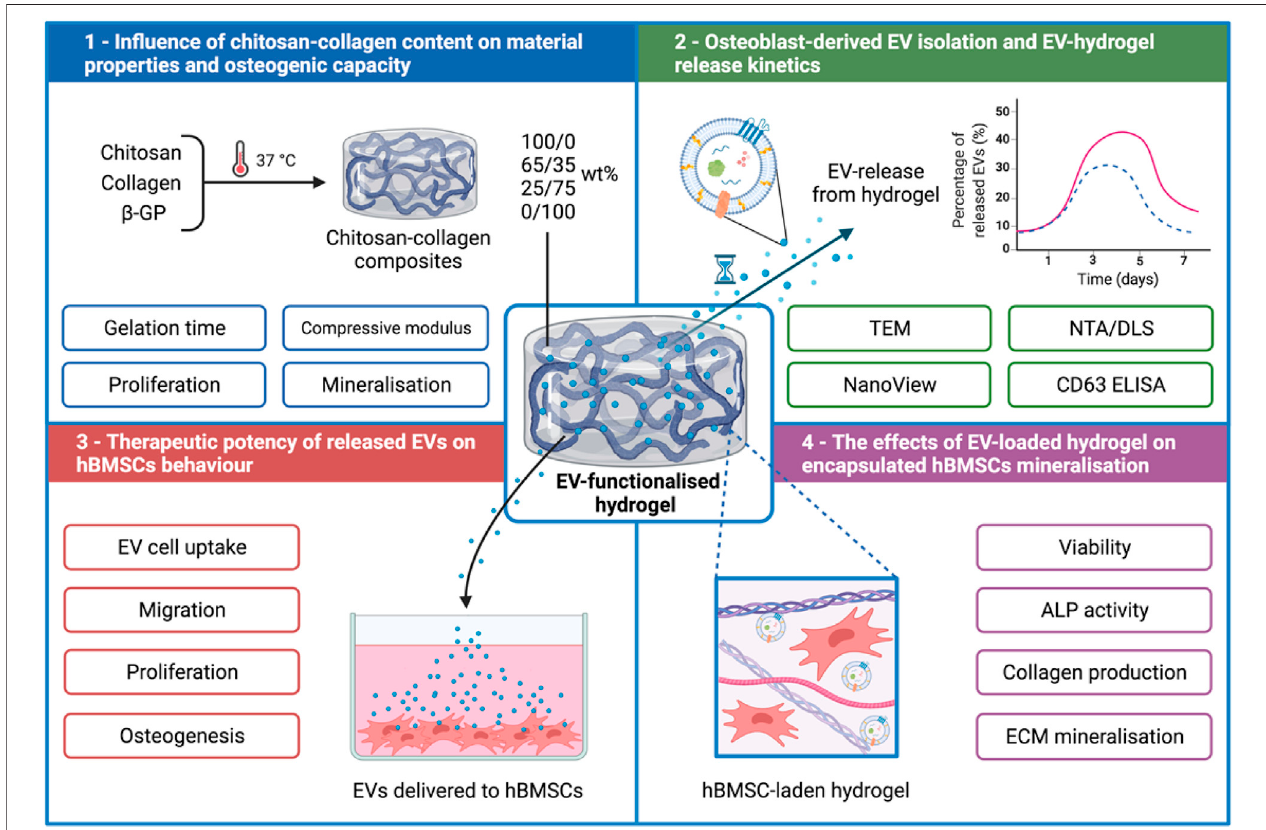
FIGURE 1 | Experimental outline detailing the development of a chitosan-collagen composite hydrogel for promoting EV therapeutic ef fi cacy for site speci fi c bone regeneration.1)Thein fl uenceofchitosan-collagenhydrogelcontentonmaterialpropertiesandosteogenicdifferentiation.2)EVisolation,characterisation,andhydrogel- EV release kinetics. 3) The biological ef fi cacy of hydrogel-released EVs on hBMSCs behaviour. 4) The in fl uence of EV-functionalised hydrogel on encapsulated hBMSCs mineralisation. Created with